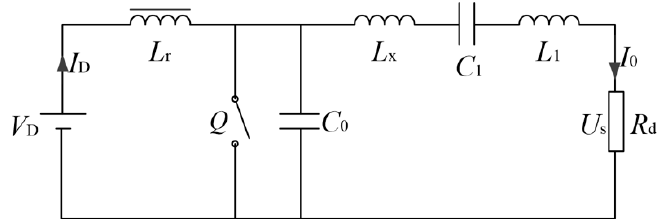
Figure 2. Equivalent circuit of class E power amplifier.